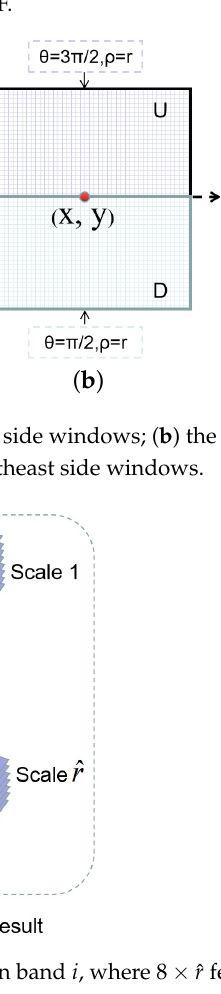
Figure 2. Definition of the SWF.